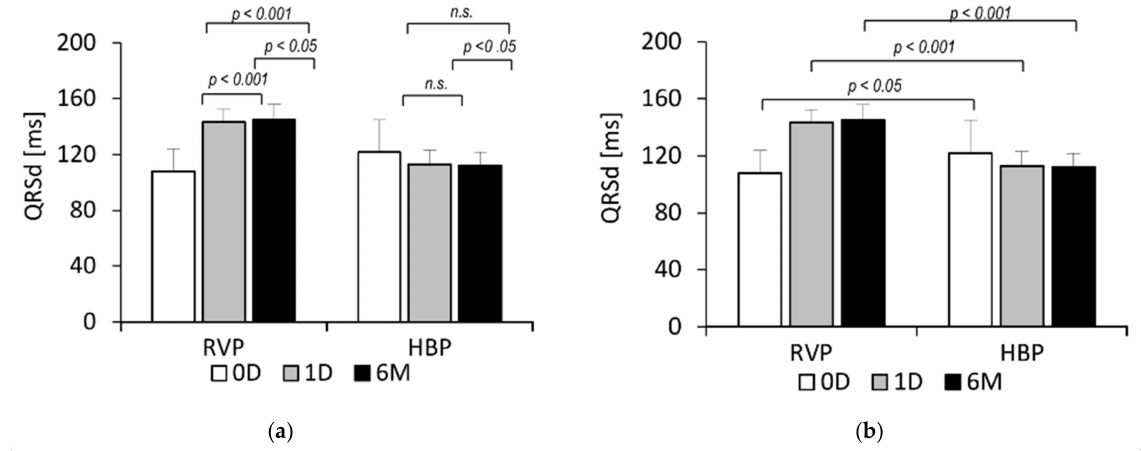
Figure 1. QRS complex duration (QRSd) in patients with right ventricular pacing (RVP) and His bundle pacing (HBP), at baseline (0D), immediately after pacemaker implantation (1D) and 6 months later (6M). Statistical analysis presented: ( a ) within and ( b ) between the studied groups of patients.